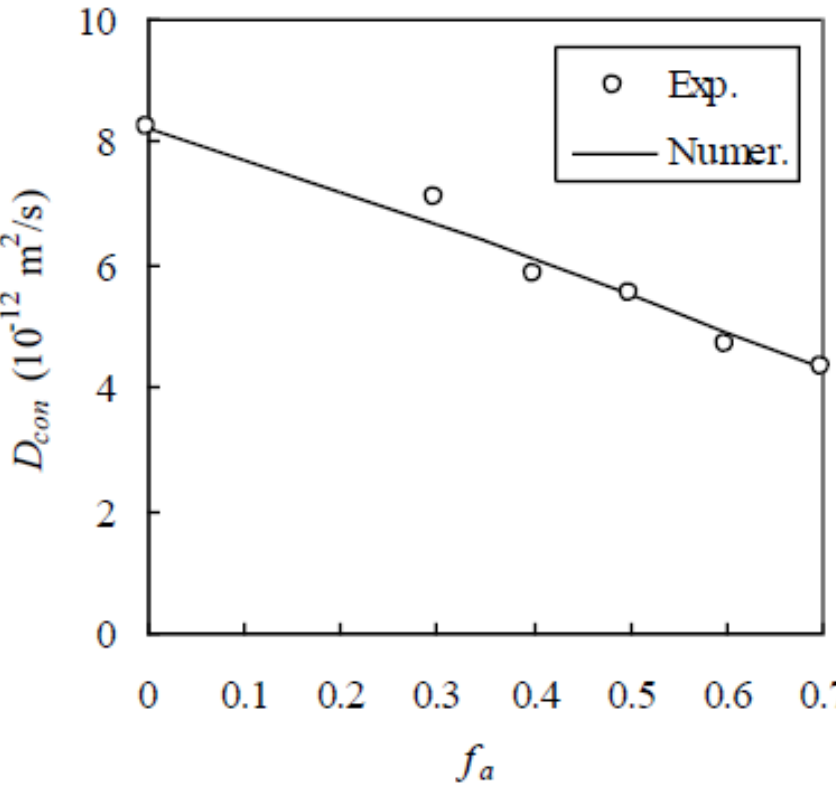
Figure 15. Comparison of numerical method with experimental results of Zheng and Zhou [37].